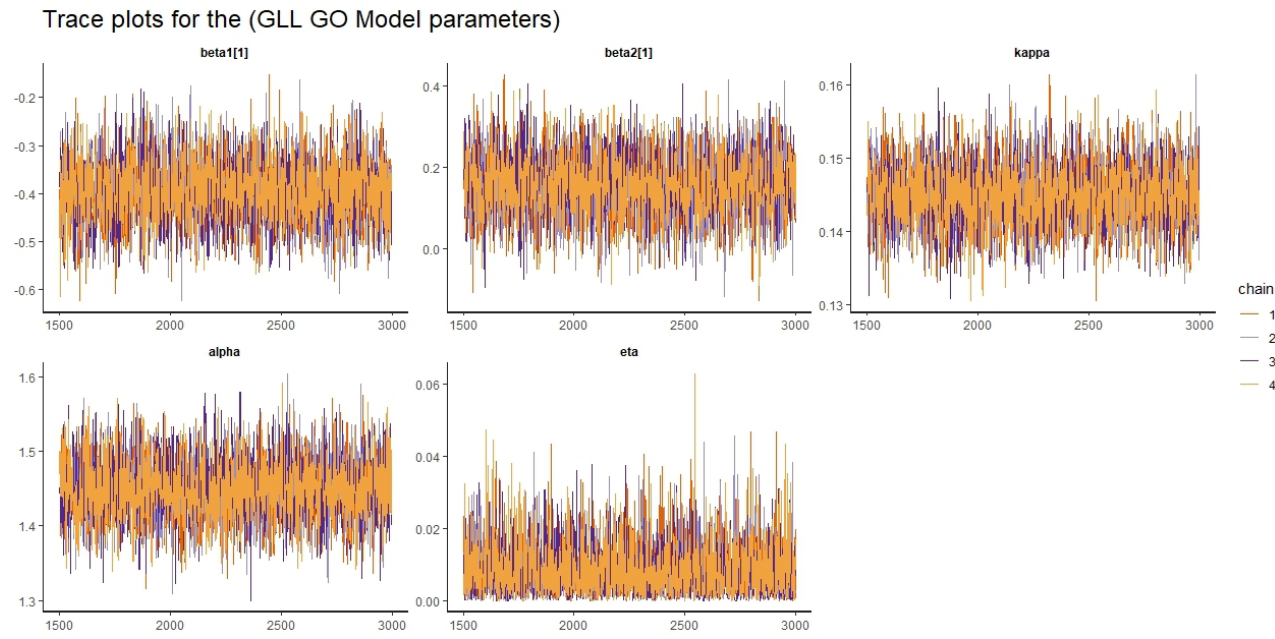
Figure 8. Trace plots for the GLL − GO model parameters.